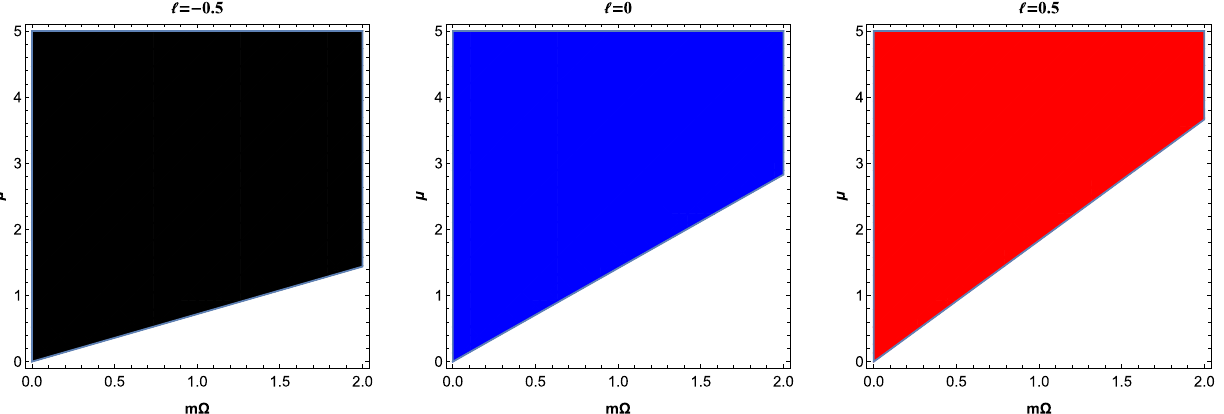
Fig. 9 Parameter space( m (cid:4) - μ ) for massive scalar field where colored area represents region with stable dynamics and non-colored area represents region with unstable dynamics. Here ˆ a = 0 . 51M and b = 0 . 01 M 2